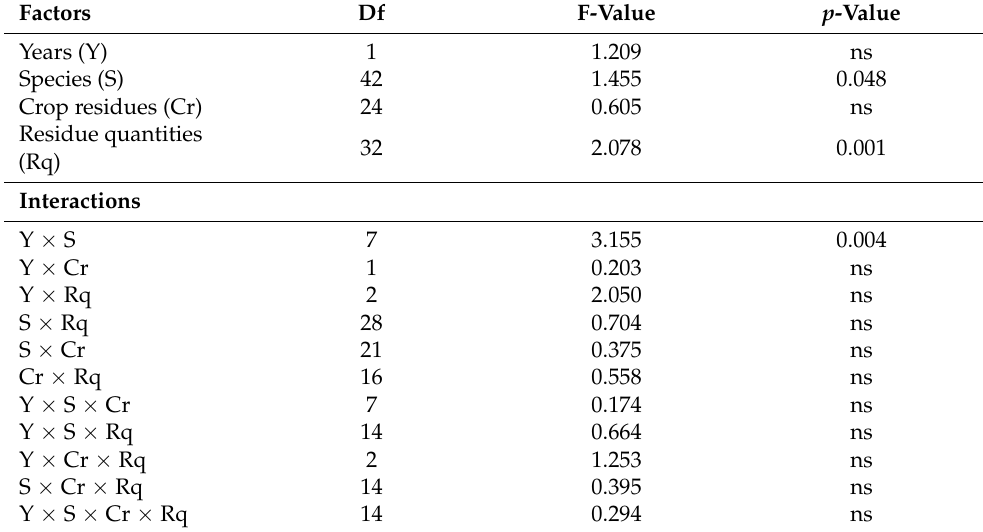
Table 2. Full factorial ANOVA on total emergence monitored in the two